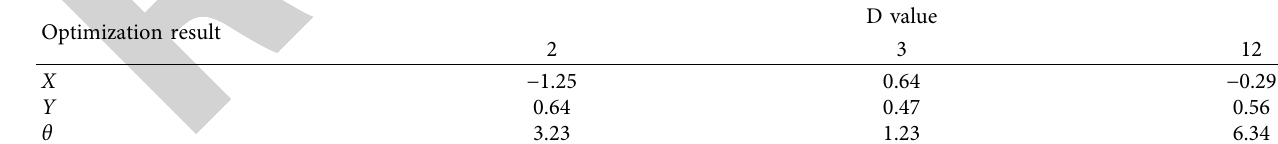
Table 10: Registration results of the translation image d with different D values.